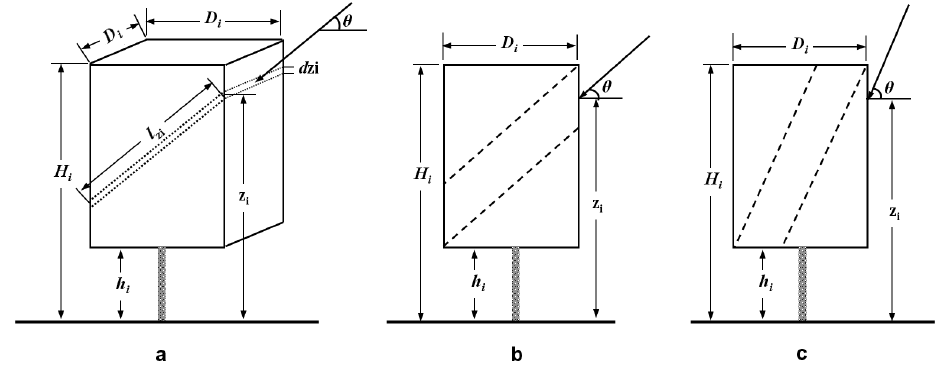
Figure 2. (a) Three-dimensional show for a light beam going through a slice of crown and the related variables. ( b and c ) Two-dimensional shows for the two cases when a light beam going through a crown.